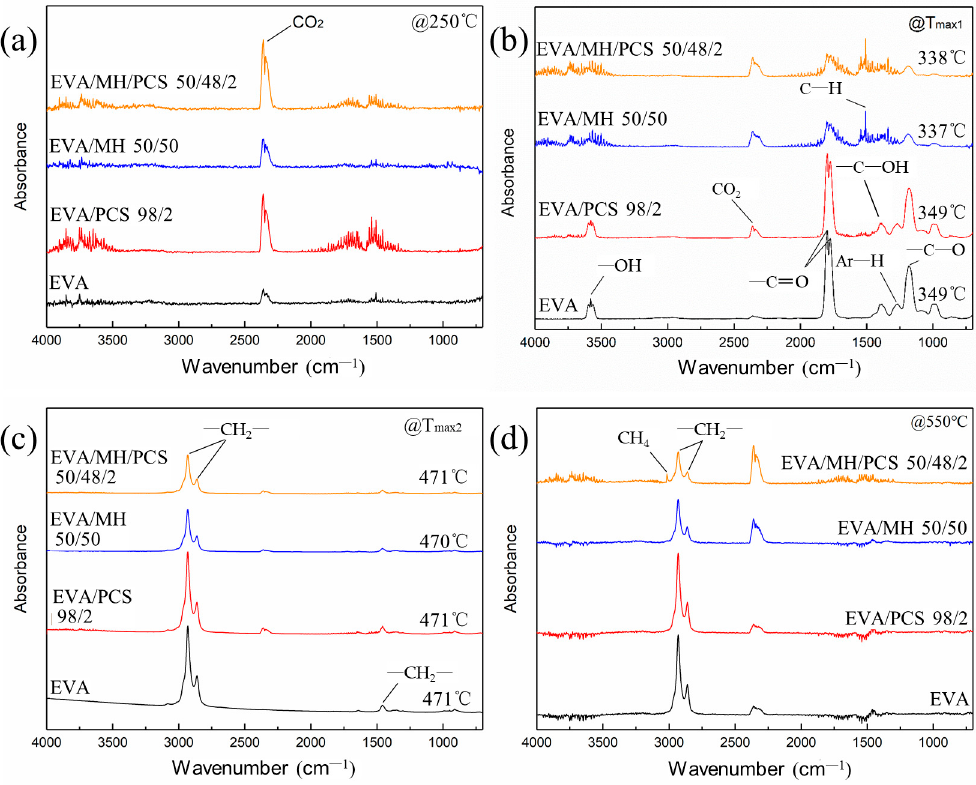
Figure 7. FTIR spectra of the degradation products of EVA and its composites at ( a ) 250 °C, ( b ) Tmax 1 , ( c ) Tmax 2 , and ( d ) 550 °C. Table 3. Assignments of the IR bands to vibrational modes of atomic groups.